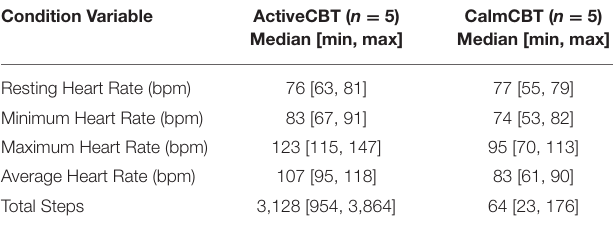
TABLE 2 | Condition